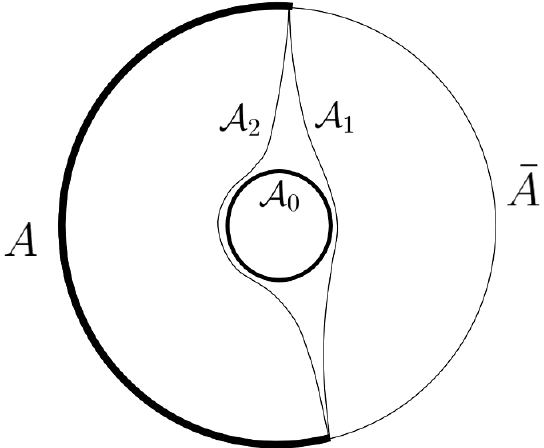
Figure 1 . A black hole with horizon area A 0 in AdS-space. The boundary is separated into two regions, A and (cid:22) A with shared boundary @A . There are two important bulk minimal surfaces with boundary @A . The minimal surface homologous to (cid:22) A has area A 1 , while the minimal surface homologous to A has area A 2